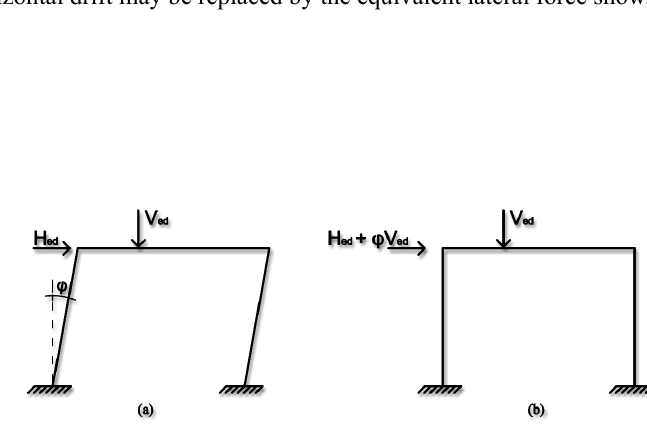
Figure 4 – Consideration of initial global imperfection by (a) initial sway; (b) equivalent lateral force (notional force). Source: Adapted from